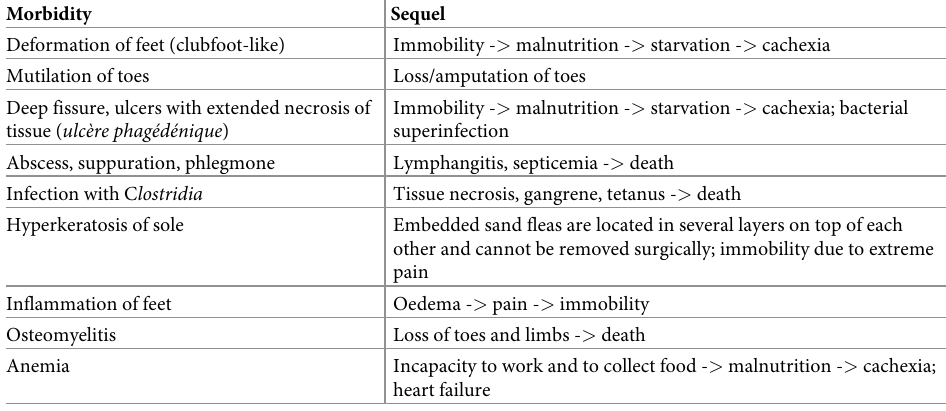
Table 3. Spectrum of morbidity and sequels in patients with very severe